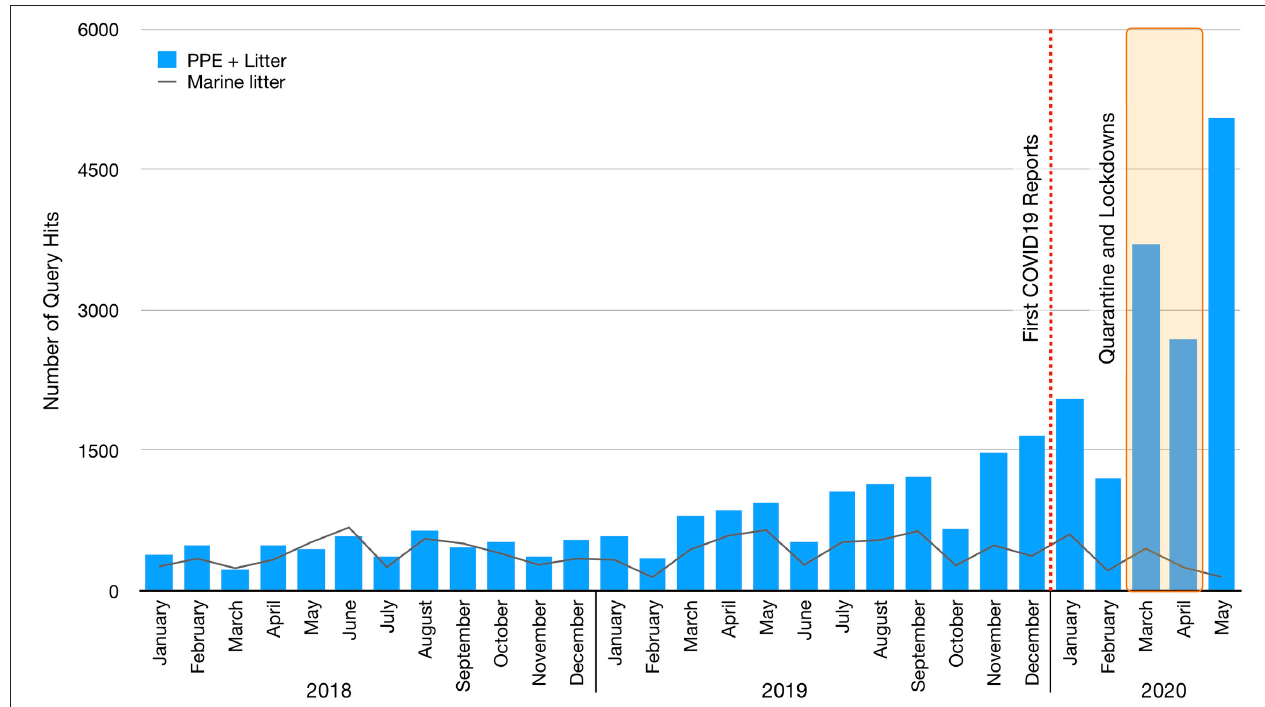
FIGURE 1 | Google News query hits per month on PPE and litter (blue columns) and on marine litter (solid line) for the period from January 2018 to May 2020. Queries in the News section included the criteria “PPE” OR “Personal Protection Equipment” AND “Litter” AND “Marine Litter”, respectively. The dashed red line marks the first COVID-19 reports in China, while orange box marks the period when most countries enforced containment measures (i.e., mandatory confinement, travel bans, border closing, and